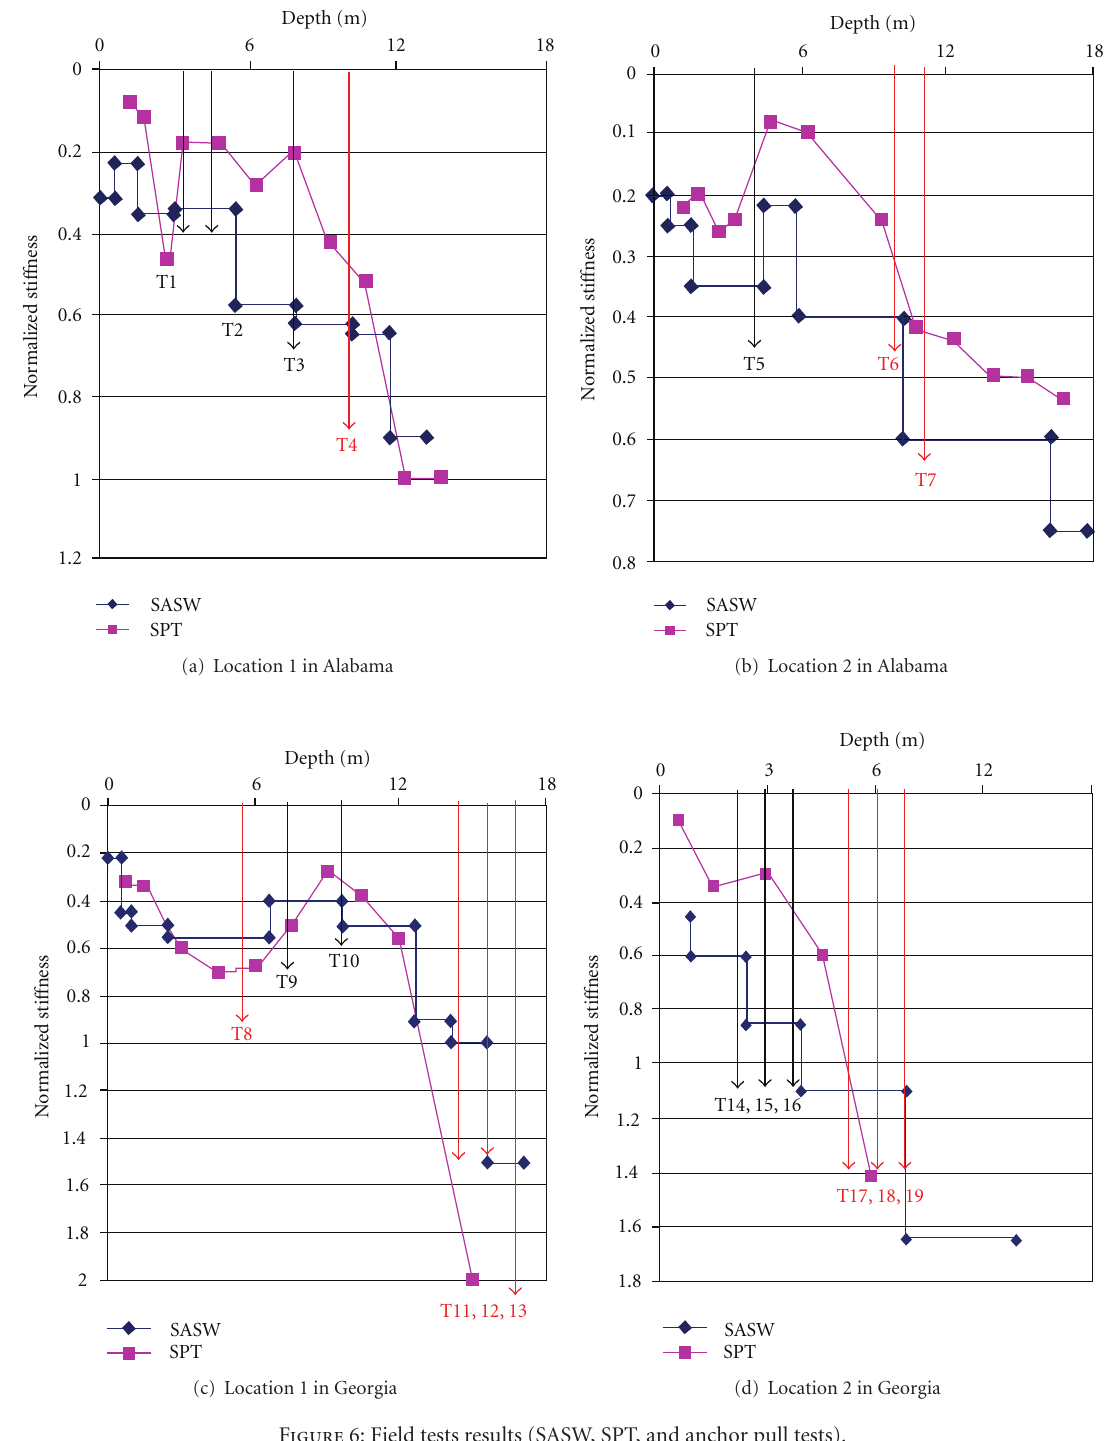
Figure 6: Field tests results (SASW, SPT, and anchor pull